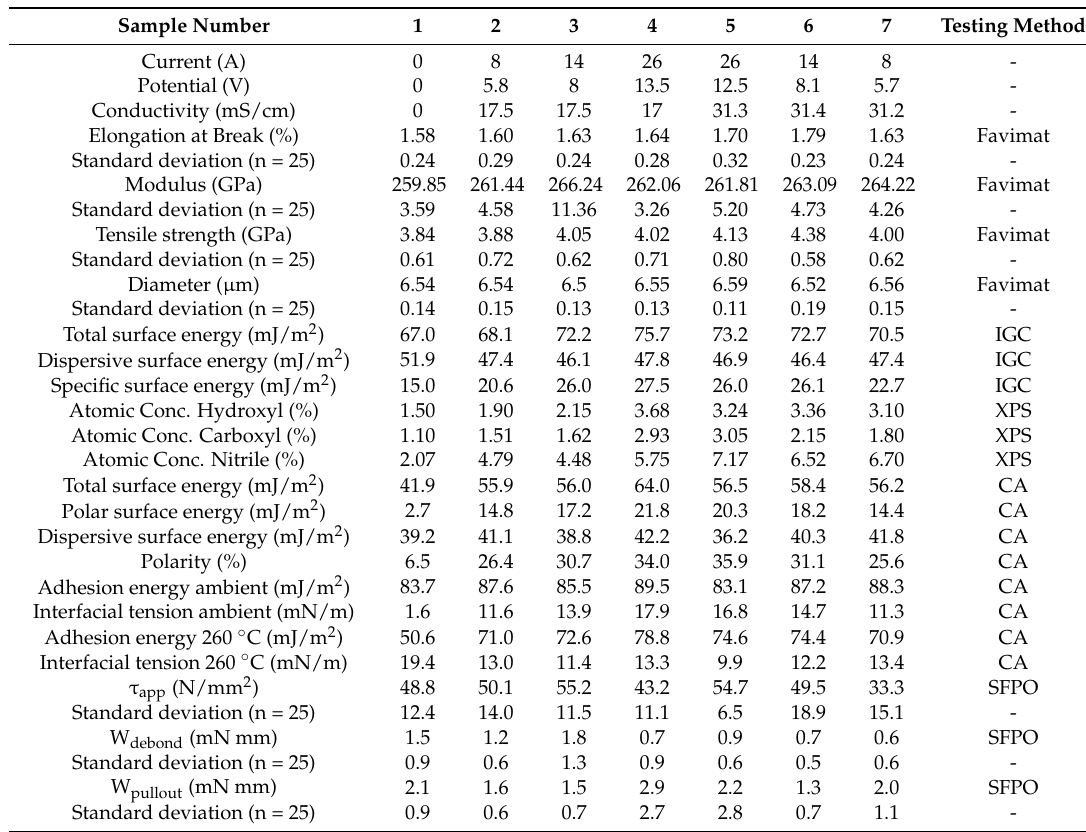
Table 3. Complete overview of process settings and associated test